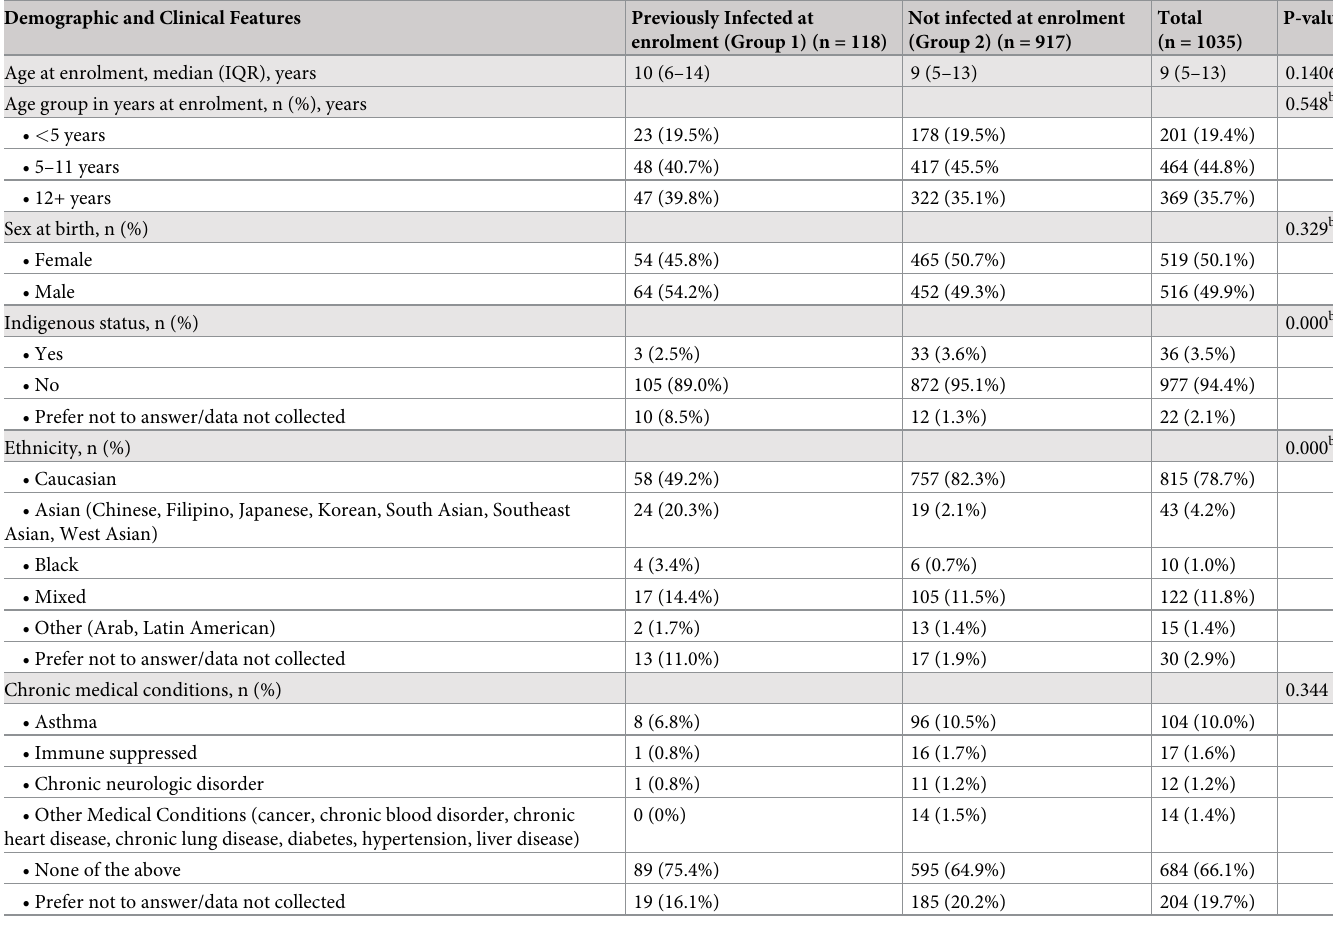
Table 1. Demographic and clinical characteristics of the sample at Visit 1. Demographic and Clinical